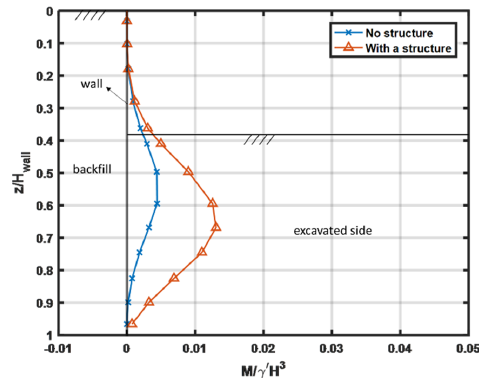
Figure 5. Normalised static bending moments in the retaining wall.